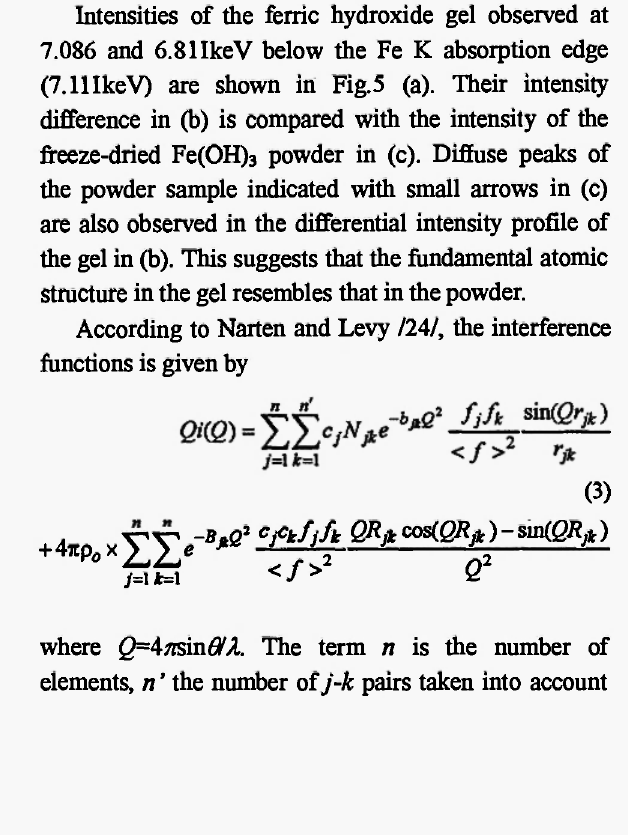
Fig. 4: Environmental RDFs for Zn ions (solid curves) and total RDFs (broken curves) in (a) 0.98 and (b) 2.85 mol/1 ZnCl aqueous 2